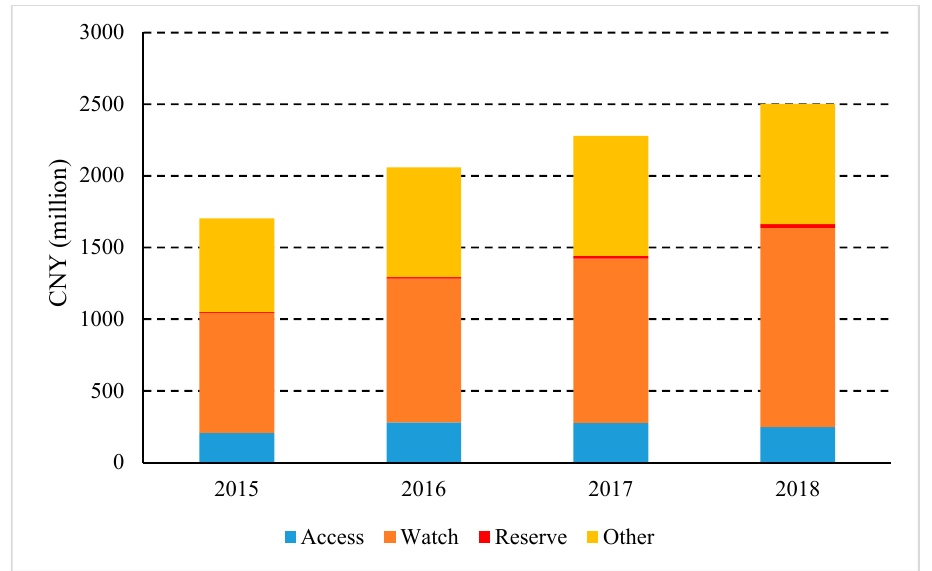
Figure 5. Consumption and expenditure of antibiotics by AWaRe categorization in Shaanxi Province, western China, 2015–2018. (DDDs, defined daily doses; CNY, Chinese Yuan; AWaRe, the “Access, Watch and Reserve” classification)